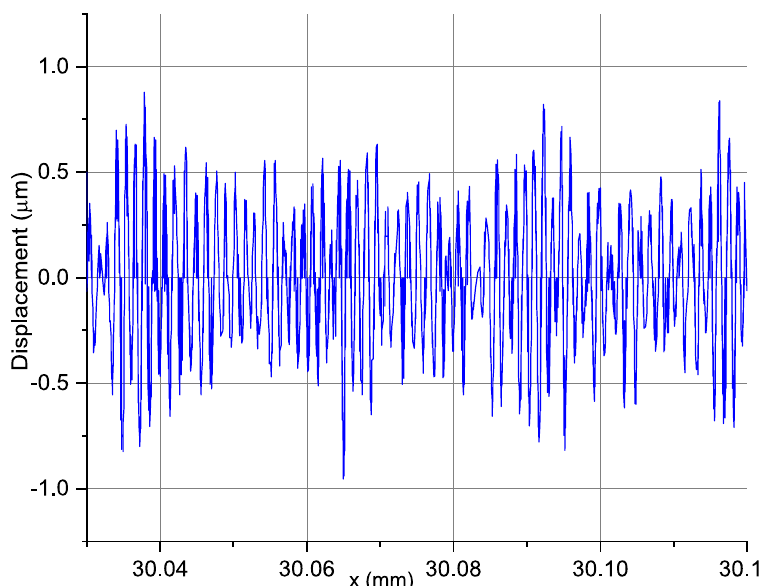
Figure 6. The signal in the range from 15 to 150 wavelengths per revolution: v c = 360 m/min; f = 0.03 mm/rev; a p = 0.35 mm; r n = 48.6 µ m; n = 2460 rpm.